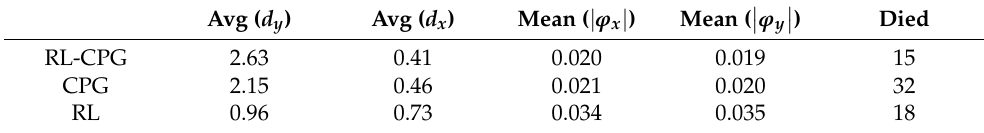
Table 2. Statistics of the experimental data of RL-CPG algorithm and traditional CPG